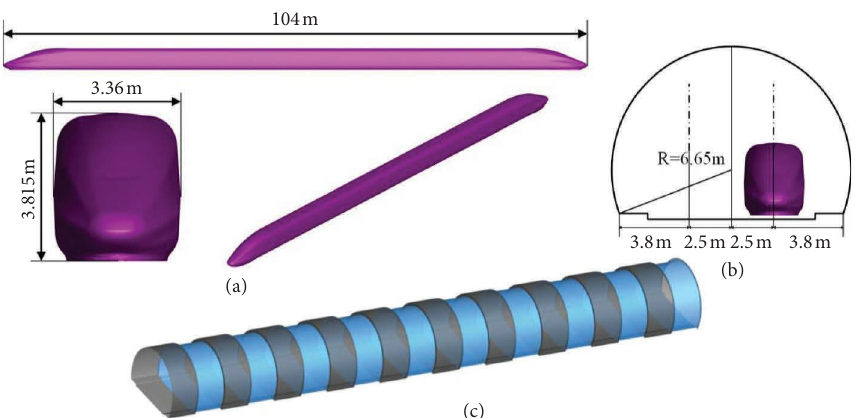
Figure 1: Schematic diagram of models. (a) Diferent views of CR400AF. (b) Tunnel section. (c) Linings.